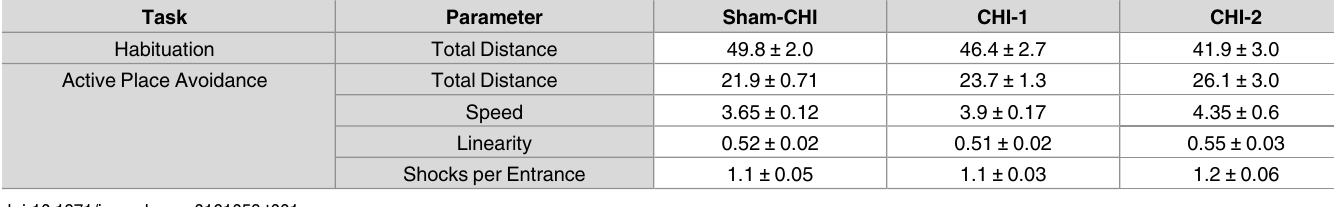
Table 1. Measurements of mouse behavior during behavioral